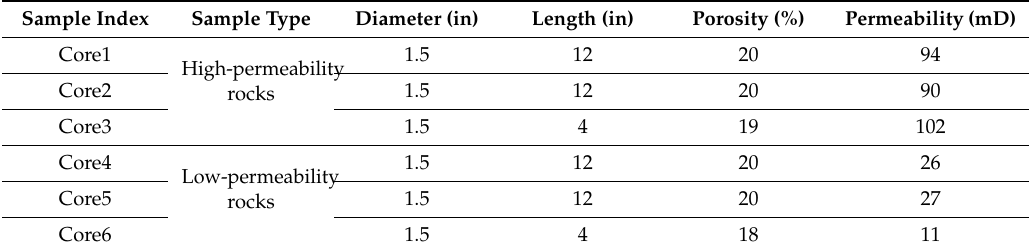
Table 4. Properties of the rock samples used in this